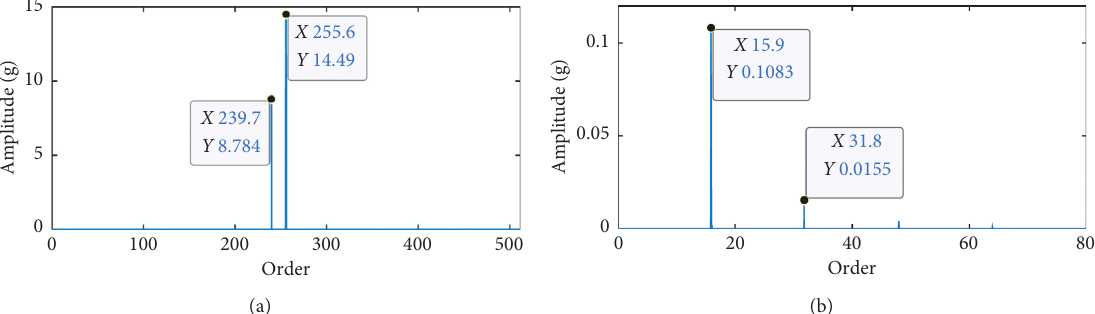
Figure 22: The extracted result of outer race fault using CS-based on MCM: (a) the detected sparse coefficients; (b) the visualized envelope order spectrum.